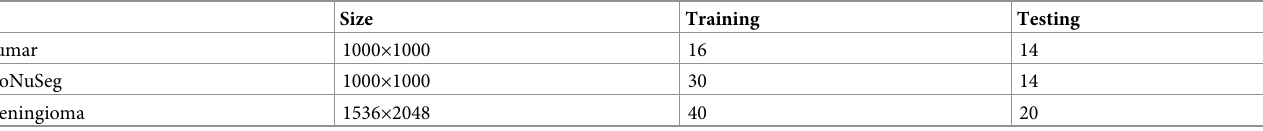
Table 2. Division of original images for training and testing datasets.